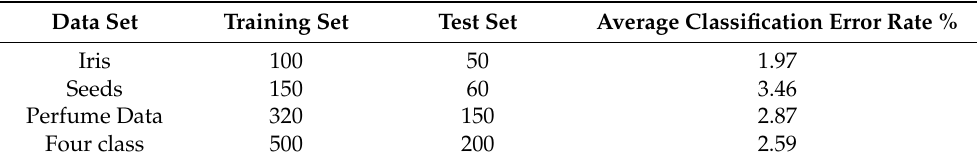
Table 1. Classification test results on different standard